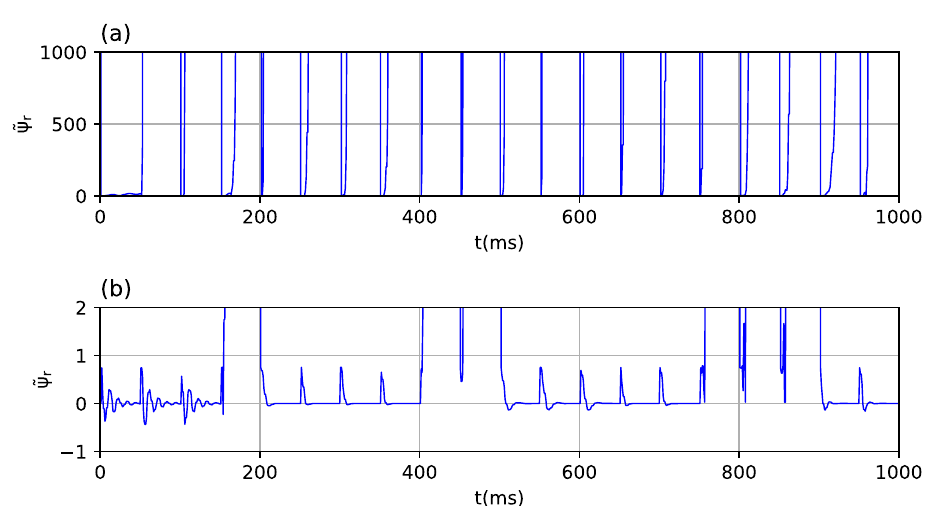
Figure 8. Rotor flux estimation error during gains selection: ( a ) in the 1st generation, ( b ) in the 10th generation.